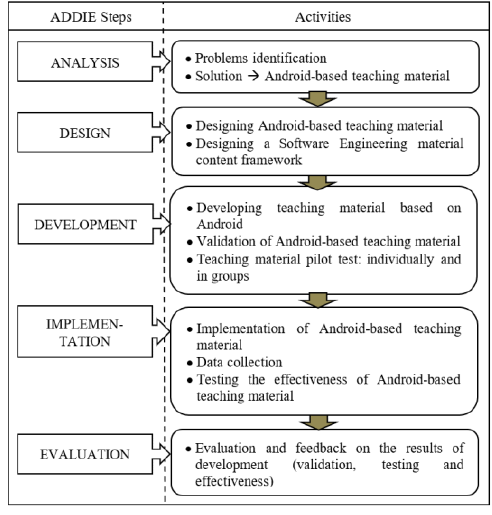
Fig. 1. ADDIE Research and Development